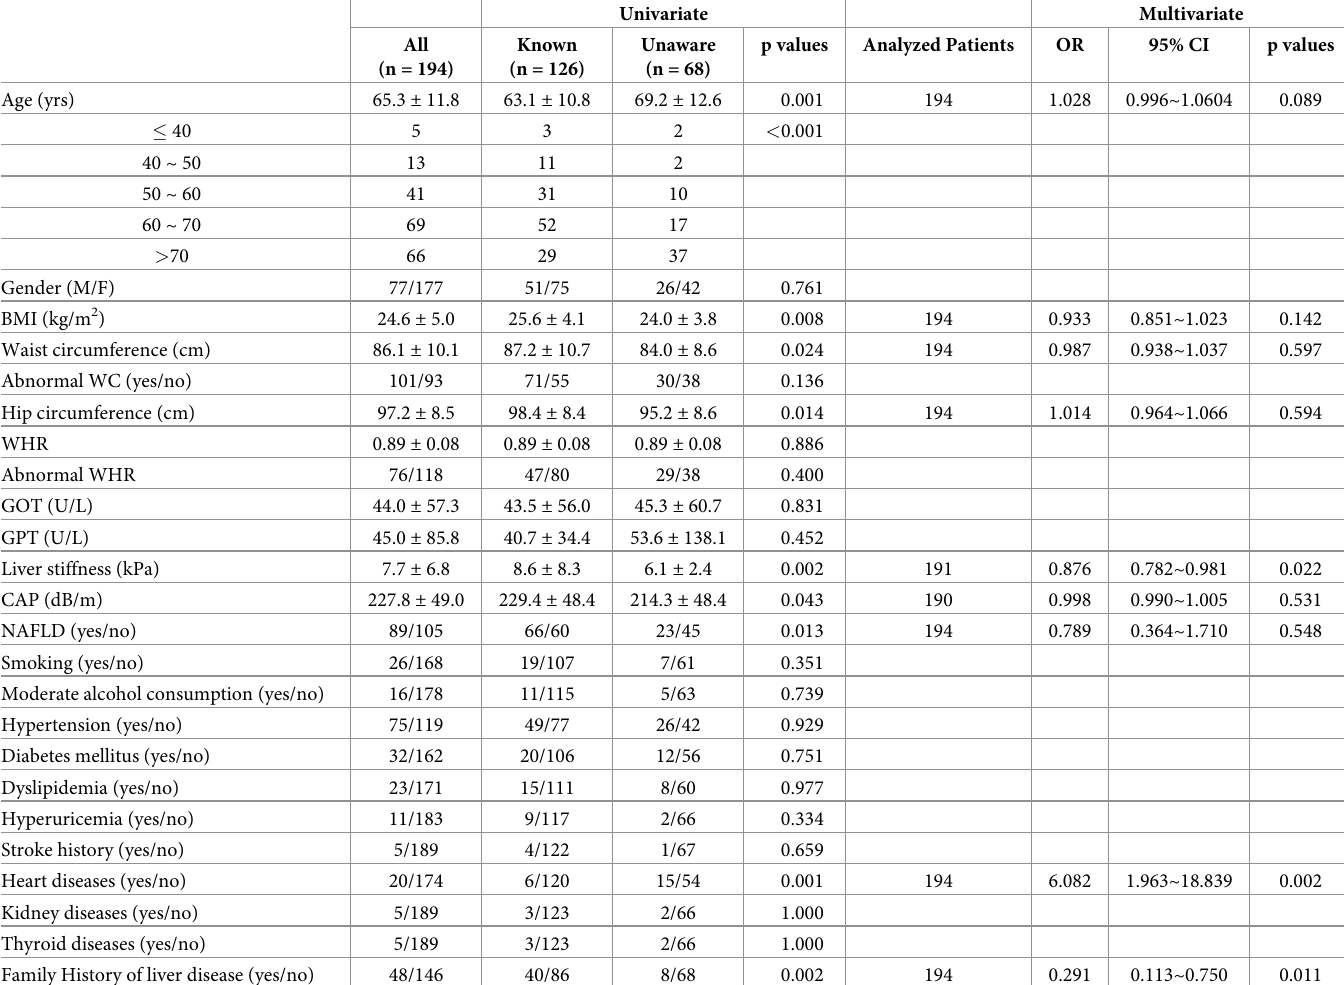
Table 2. Characteristics of positive anti-HCV Ab subjects with known or unaware HCV